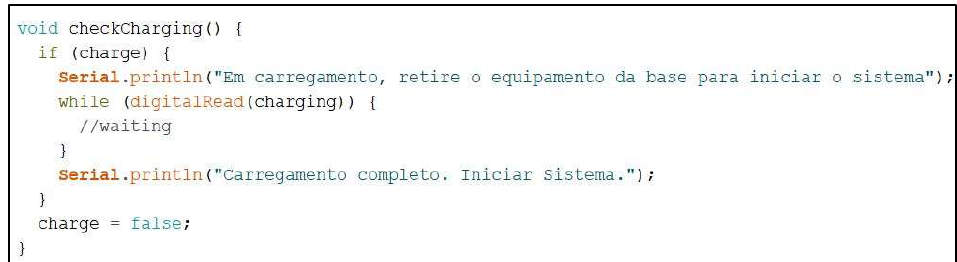
Figure 2 . Code1 — charge verification.